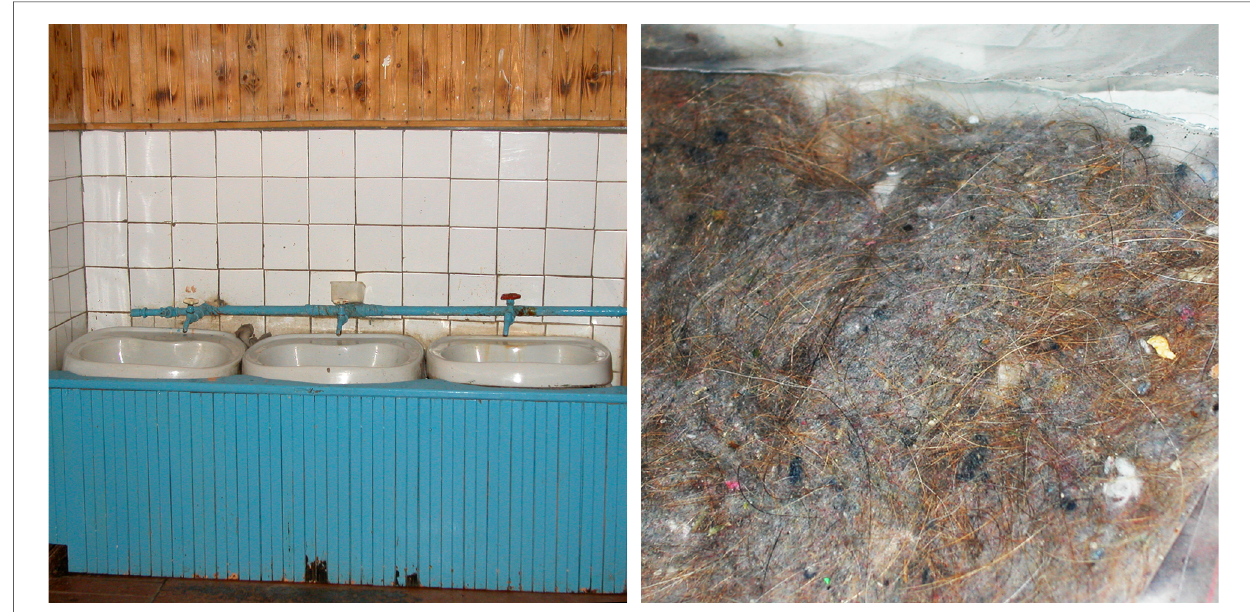
FIGURE 3 Drinking water in schools and house dust at homes contained much more microbes in Russian vs. Finnish Karelia and provided protection against allergy in Russia (42, 43). Photos: Tuula